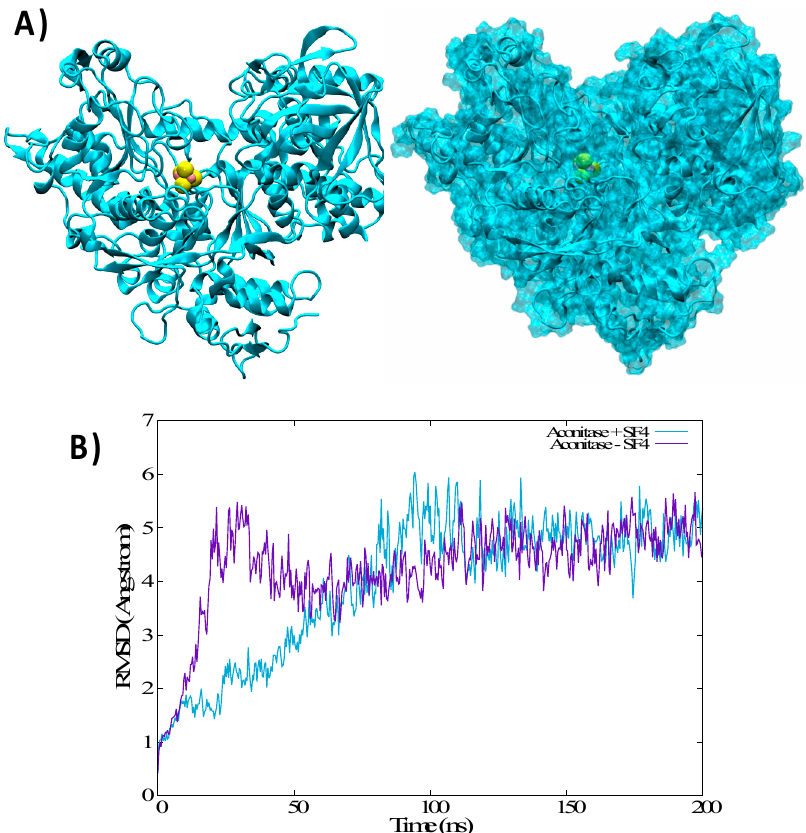
Figure 6. ( A ) representative snapshots of the cAco dynamics in cartoon and surface representation. The Fe-S cluster is highlighted in van der Walls. ( B ) Time evolution of the RMSD of the cAco MD simulation in the presence and in the absence of the Fe-S cluster.